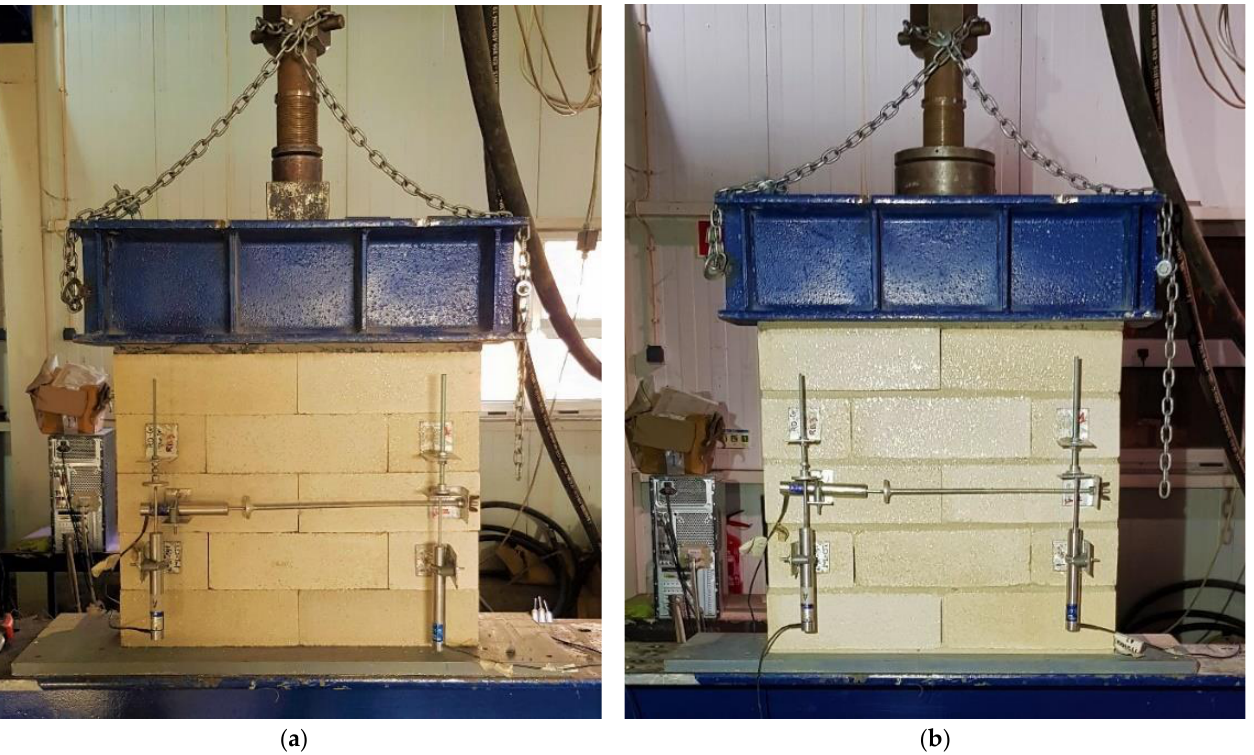
Figure 7. Setup of the compression tests conducted on masonry wallettes: ( a ) DSW and ( b ) MW.